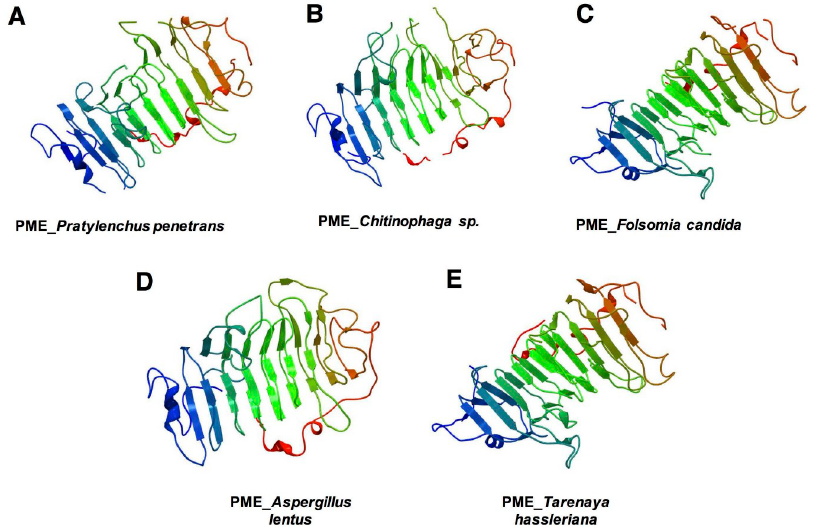
Fig 3. Three-dimensional model predicted for the pectin methylesterase of different organisms. (A) Pratylenchus penetrans , (B) bacteria ( Chitinophaga sp.), (C) collembolan ( Folsomia candida ), (D) fungi ( Aspergillus lentus ), and (E) plants ( Tarenaya hassleriana ). The models of P . penetrans and Chitinophaga sp. were based on the three-dimensional model of the Erwinia chrysanthemi (Phyre2 fold library ID: d1gq8a), F . candida and T . hassleriana were based on the model of Daucus carota (Phyre2 fold library ID: d1qjva), and A . lentus on the model of A . niger (Phyre2 fold library ID: c5c1cA), respectively. The N-terminal is indicated in blue and the C-terminal is shown in red. https://doi.org/10.1371/journal.pone.0212540.g003 with bacterial PMEs of the Proteobacteria phylum, while the PMEs of the whitefly B . tabaci (family Aleyrodidae, Hemiptera) grouped with a monophyletic clade formed by fungi only. As denoted by the protein alignment described above, Pp-PME clustered with bacterial sequences of the phylum Bacteriodetes (80% bootstrap value), including the soil collembolan F . candida (family Isotomidae, Collembola), although with a lower bootstrap value. All remaining PME sequences of bacteria (Phylum Firmicutes) and Archaea formed well-separated sub-clusters. Table 1. List of top BLAST hit sequences obtained by BLASTp analyses (E-value < 1e-5) using P . penetrans PME as query. Species Accession no. Organism BLASTp Identity (Phylum: Family) (E-value)